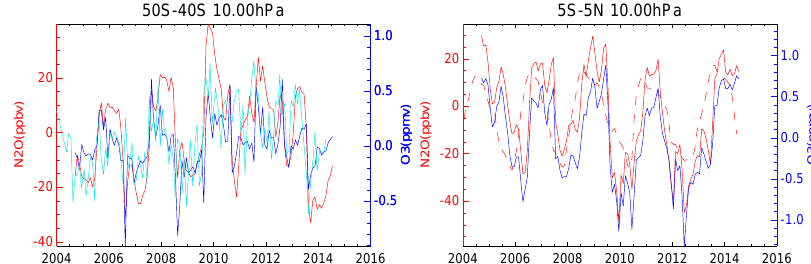
Figure 9. Monthly average anomalies for N 2 O (red) and O 3 (blue) as measured by MLS at 10hPa within 5 ◦ of the Lauder latitude (45 ◦ S) (left) and within 5 ◦ of the equator (right). The left hand plot also shows the monthly average O 3 anomalies (based on the 2004–2014 averages) for MOPI (cyan). The right hand plot also shows (dashed red line) the 30hPa QBO index in ms − 1 , using the same numerical scale as the N 2 O in ppbv.